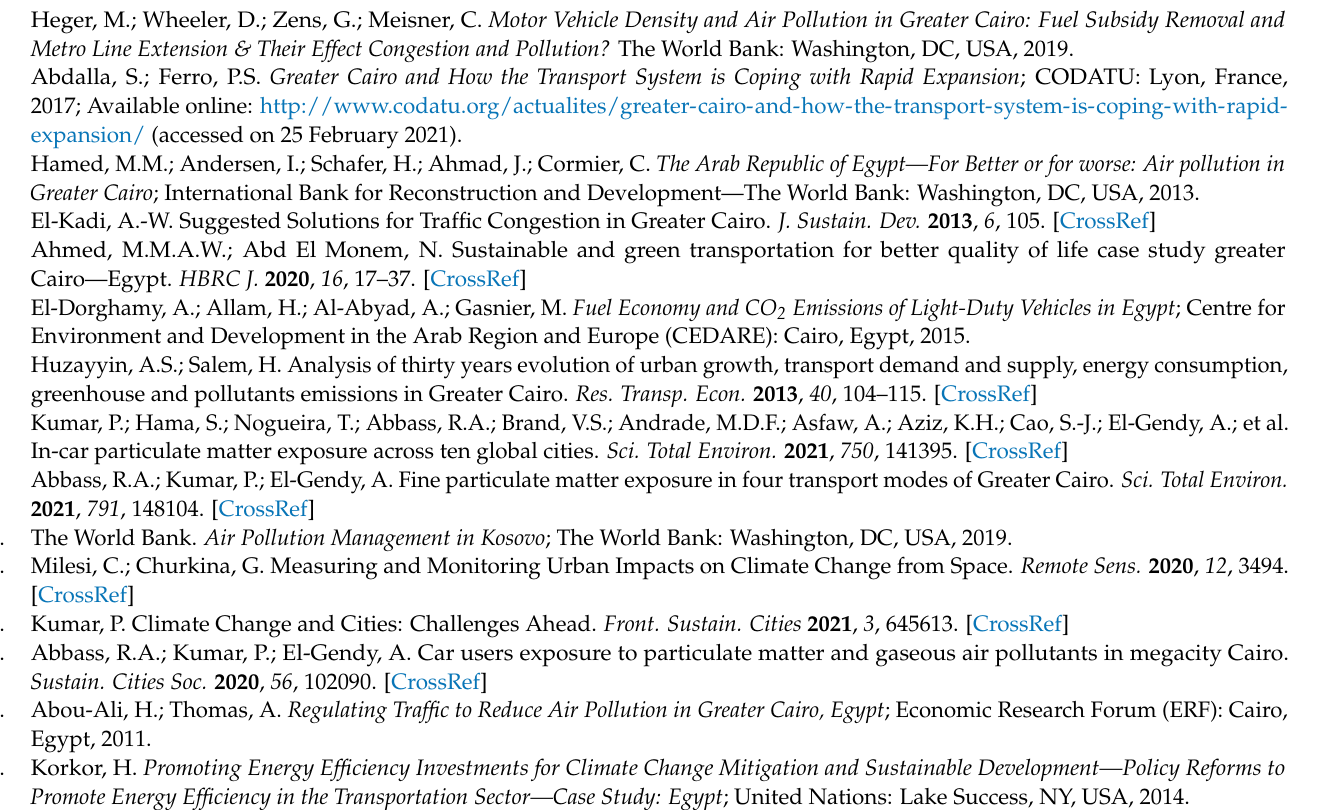
network map. Figure S2: Greater Cairo 2019 vehicle mix. Figure S3: Hourly VKT over 1 day in kilometers for the five vehicle types are shown in the above bar charts for the three road types (a) arterial, (b) highway, and (c) residential. Figure S4: Hourly number of starts over 1 day for the five vehicle types are shown in the above bar charts for the three road types (a) arterial, (b) highway, and (c) residential. Figure S5: Percent distribution of emission quantities for 1 day for 2019 base case. Table S1: Fleet file